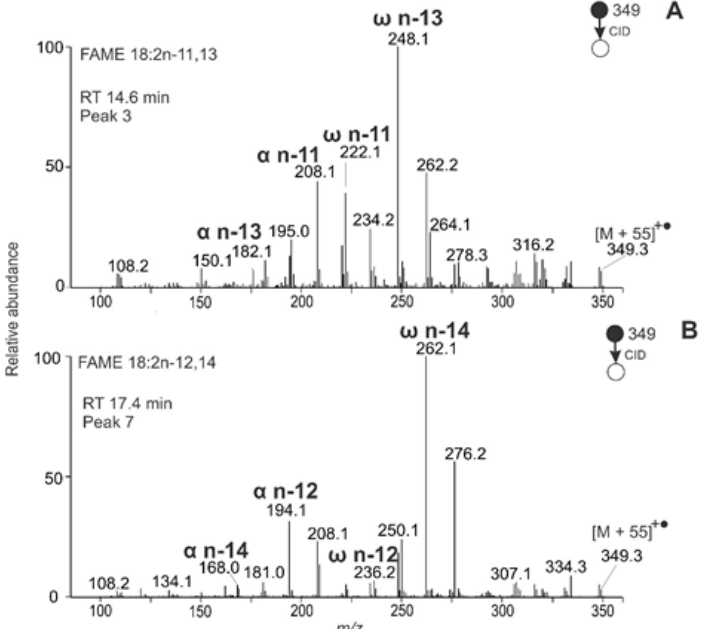
Figure 10. APCI MS/MS spectra of the [M + 55] +• adducts of allenic FAMEs from Marrubium vulgare